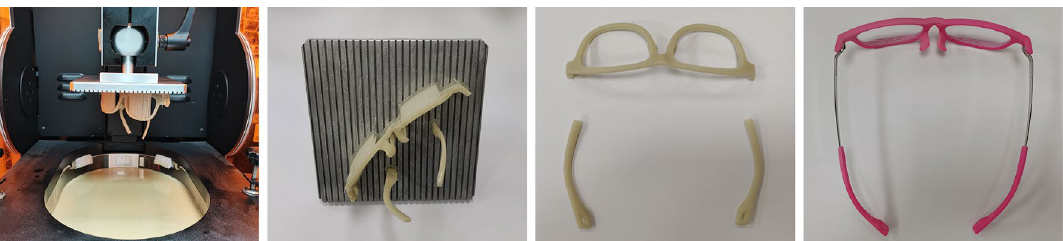
Figure 26. Glasses manufacturing. From left to right: the glasses fabricated by the 3D printer, the glasses with supports in the 3D printer platform, the glasses supports cleared manually, and the glasses polished, painted and assembled.